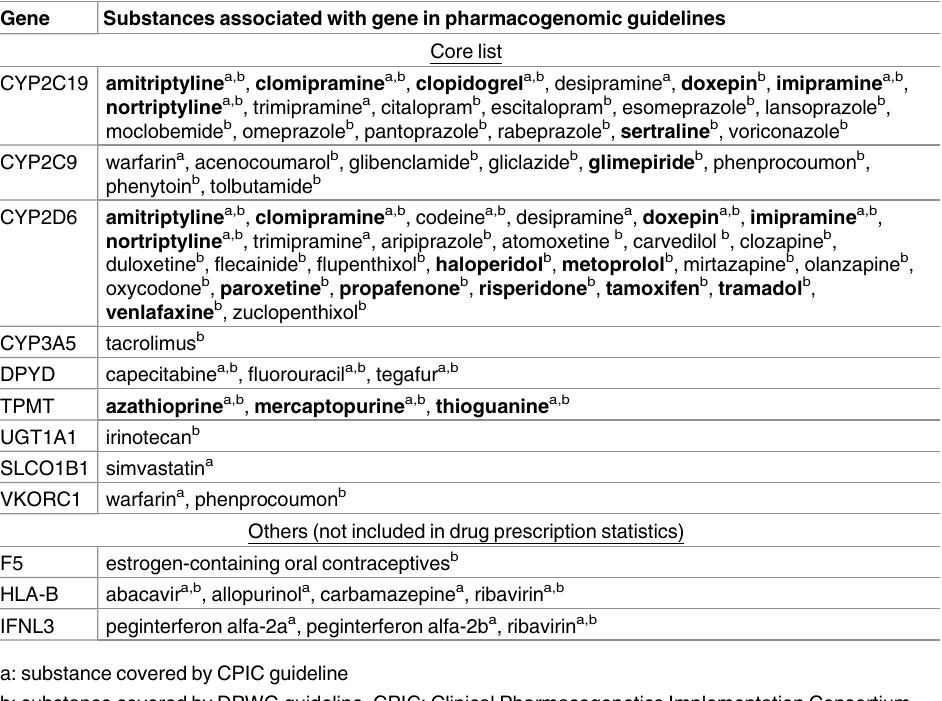
Table 3. Overview of drugs for which CPIC or DPWG guidelines were available at the time of our anal- ysis (mid-2014). Drugs and substances that we assignedto the ‘core list’ are listed separately. Only ‘core list’ substanceswere used for generating prescription statistics. Drug substancesthat were includedin the estimation of the number of high-risk drug-phenotype co-occurrences are printed in bold. Gene Substances associated with gene in pharmacogenomic